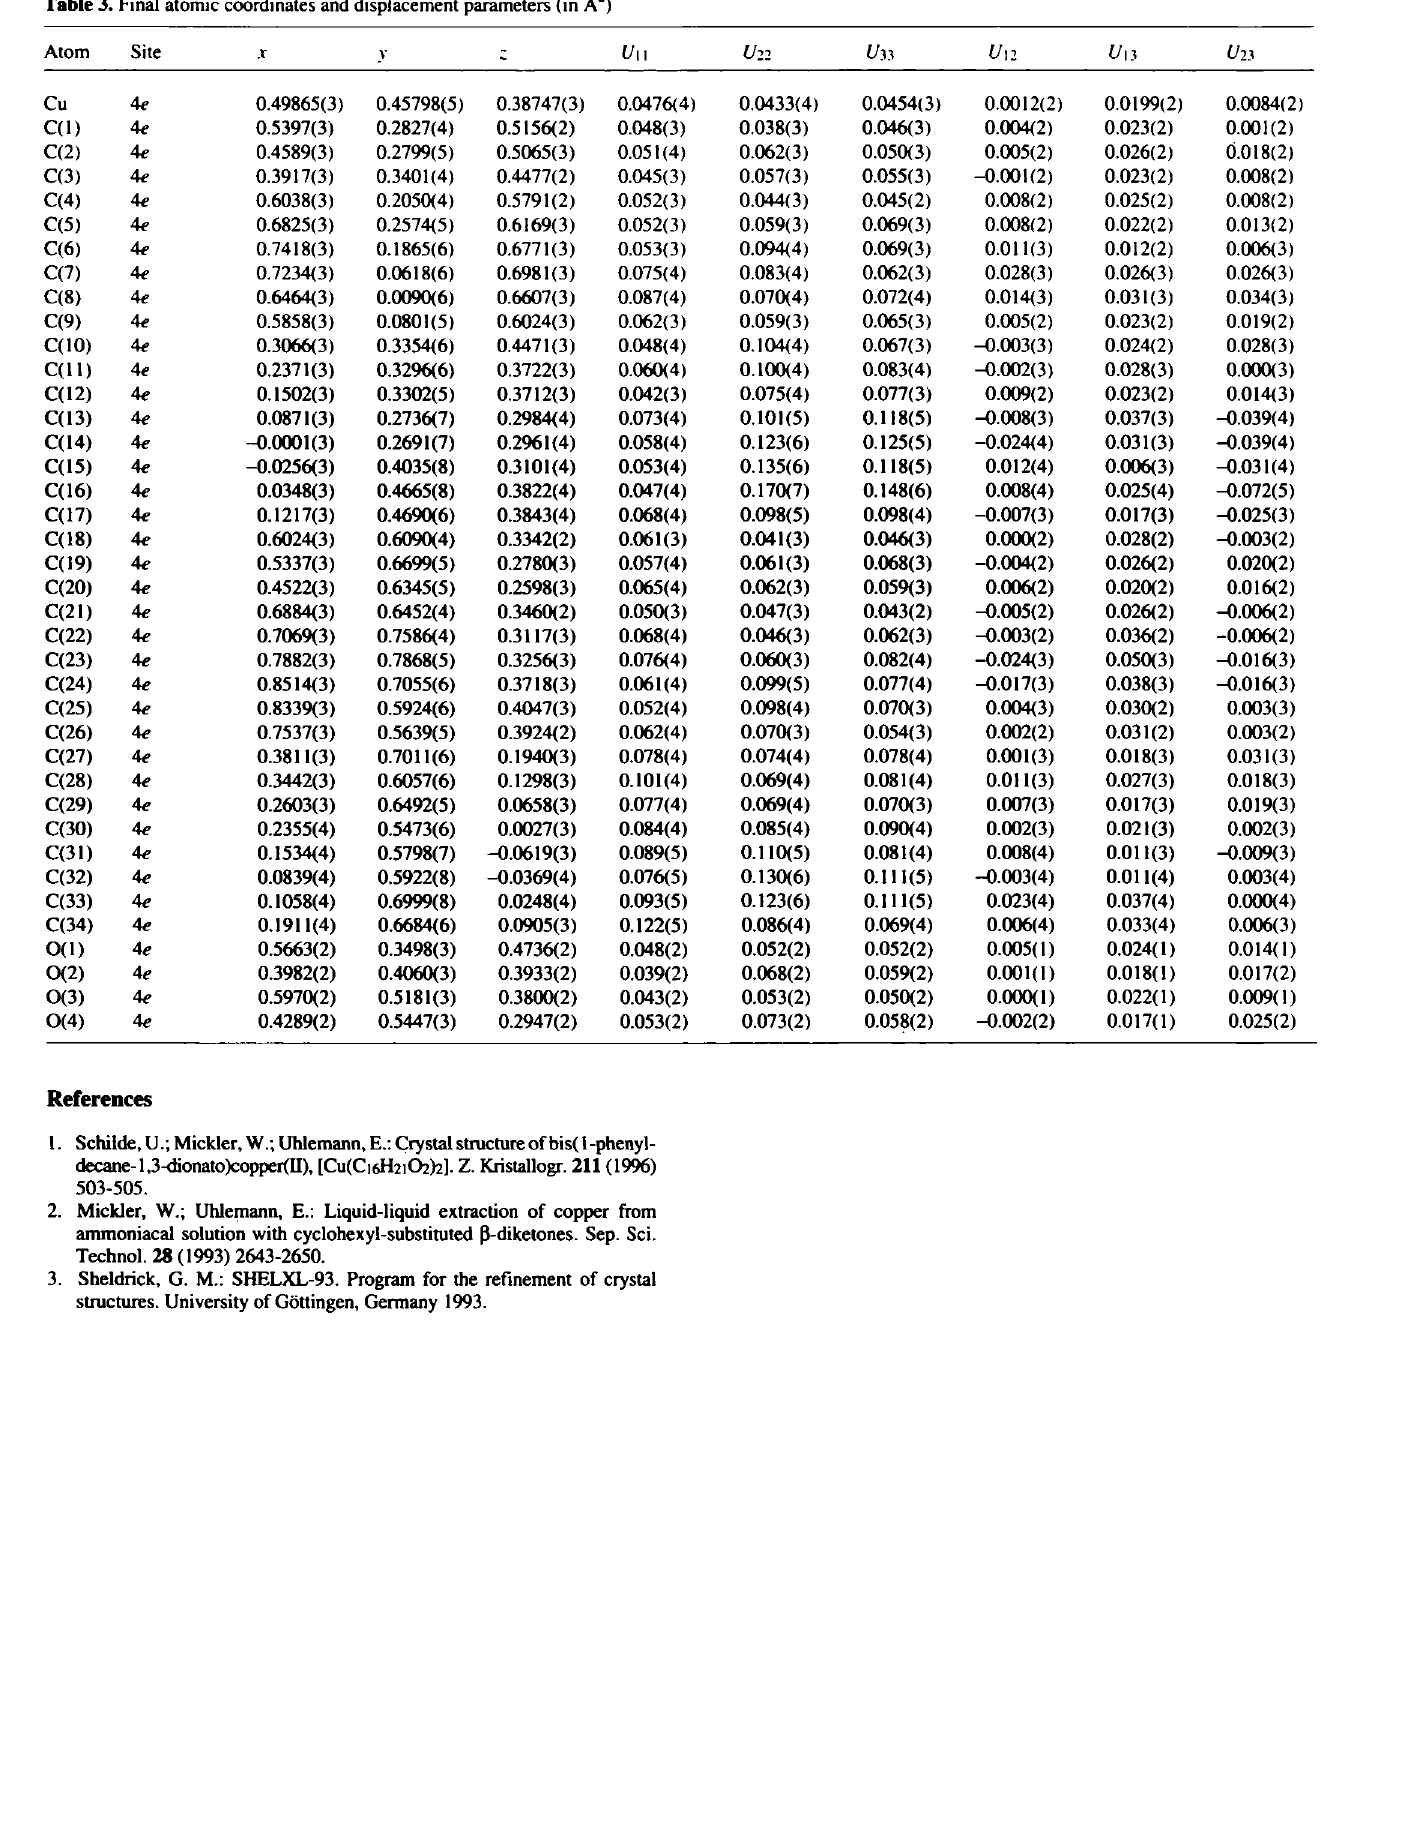
Table 3. Final atomic coordinates and displacement parameters (in À 2 ) Atom